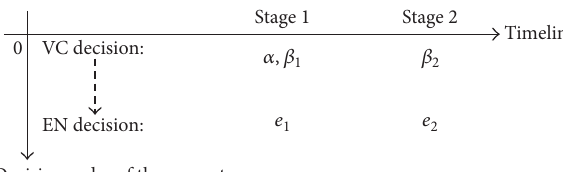
Figure 1: The game sequence and decision variables of VC and